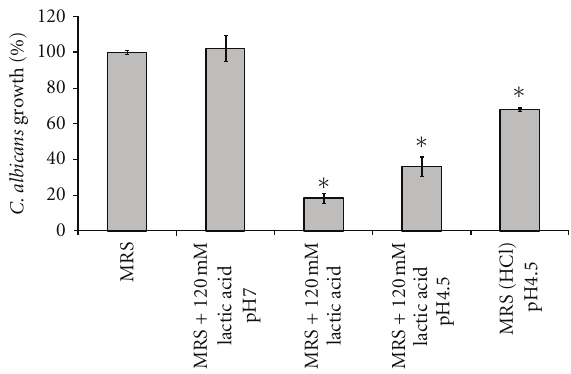
Figure 2: Inhibition of C. albicans growth by lactic acid at low pH. Microplate growth assays were used to determine the e ff ect of lactic acid on the growth of C. albicans . MRS medium was supplemented with 120 mM lactic acid and the pH was adjusted to pH 4.5 or 7.0. MRS with 120 mM lactic acid had a pH of 4.2. As a control for low pH, MRS was adjusted to pH 4.5 using hydrochloric acid (MRS (HCL)). While acidic pH slows growth of C. albicans , the strongest growth inhibition was achieved with lactic acid at low pH. This inhibitory e ff ect was completely lost by neutralization. Error bars show the standard deviations of two experiments with quadruplicate measurements. Statistical significant ( P < 0 . 01) di ff erences to all other conditions as calculated by ANOVA are indicated by asterisks.